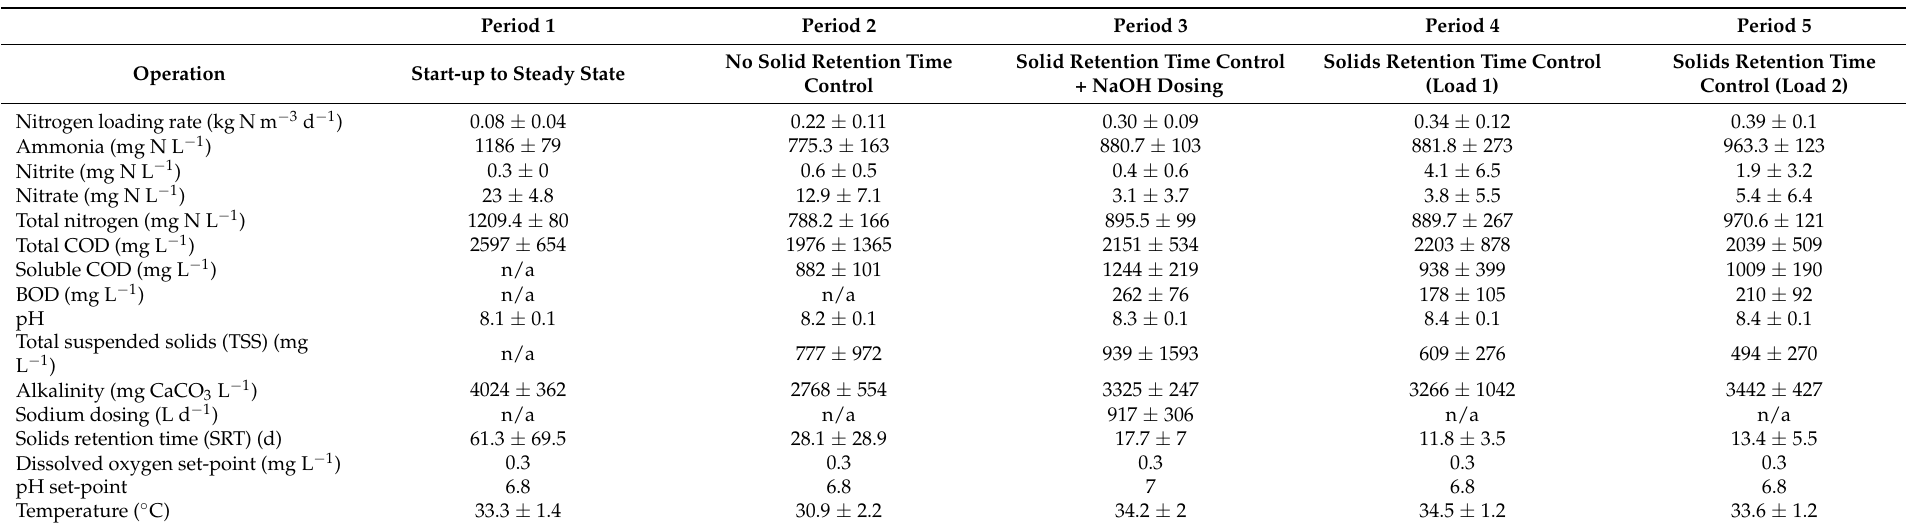
Table 1. Influent and operational characteristics of the full-scale suspended sludge deammonification continuous stirred deammonification